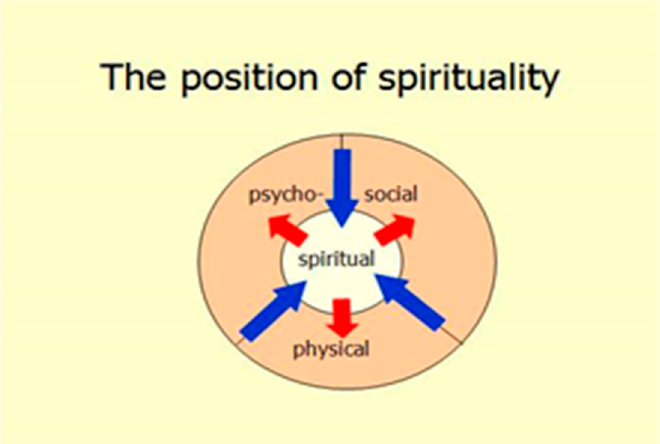
Figure 1. The relation between the four dimensions of palliative